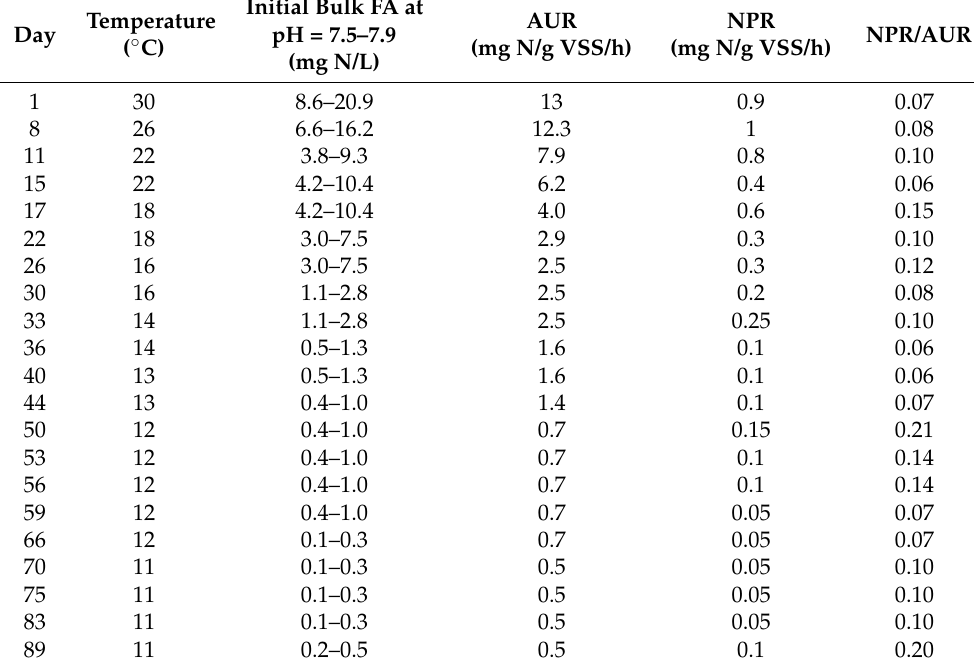
Table 1. The measured AURs and NPRs during the study period.